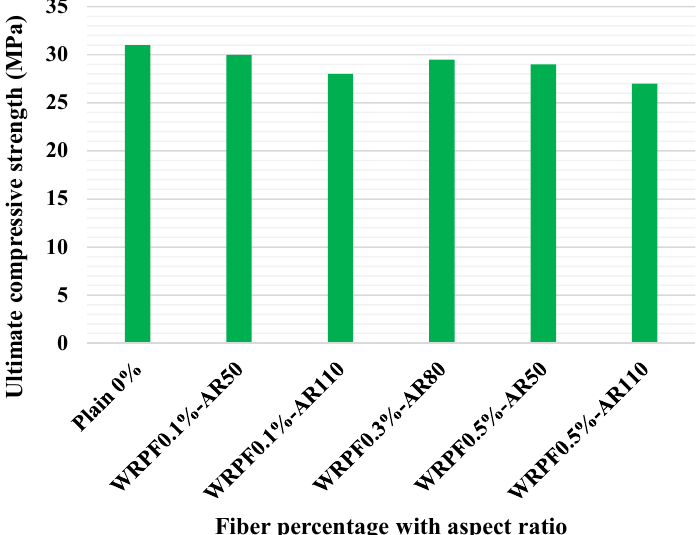
Figure 5. Ultimate CS of the control concrete and Waste recycled plastic fiber (WRPF) concrete with various fiber aspect ratios [75]. Waste recycled plastic fiber (WRPF); aspect ratio (AR).